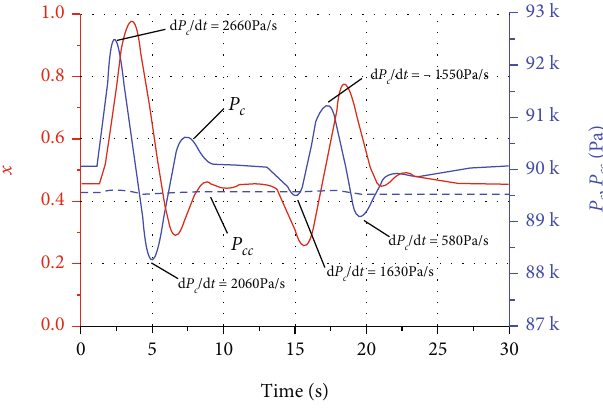
Figure 22: Relative opening of the out fl ow valve and the cabin